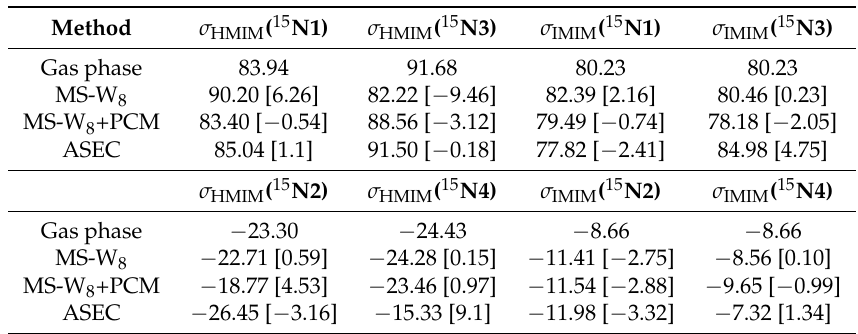
Table 3. B3LYP/6-311++G(2d,2p) results for 15 N shielding constants (in ppm) of HMIM and IMIM tetramers. Chemical shifts relative to the gas phase are represented in